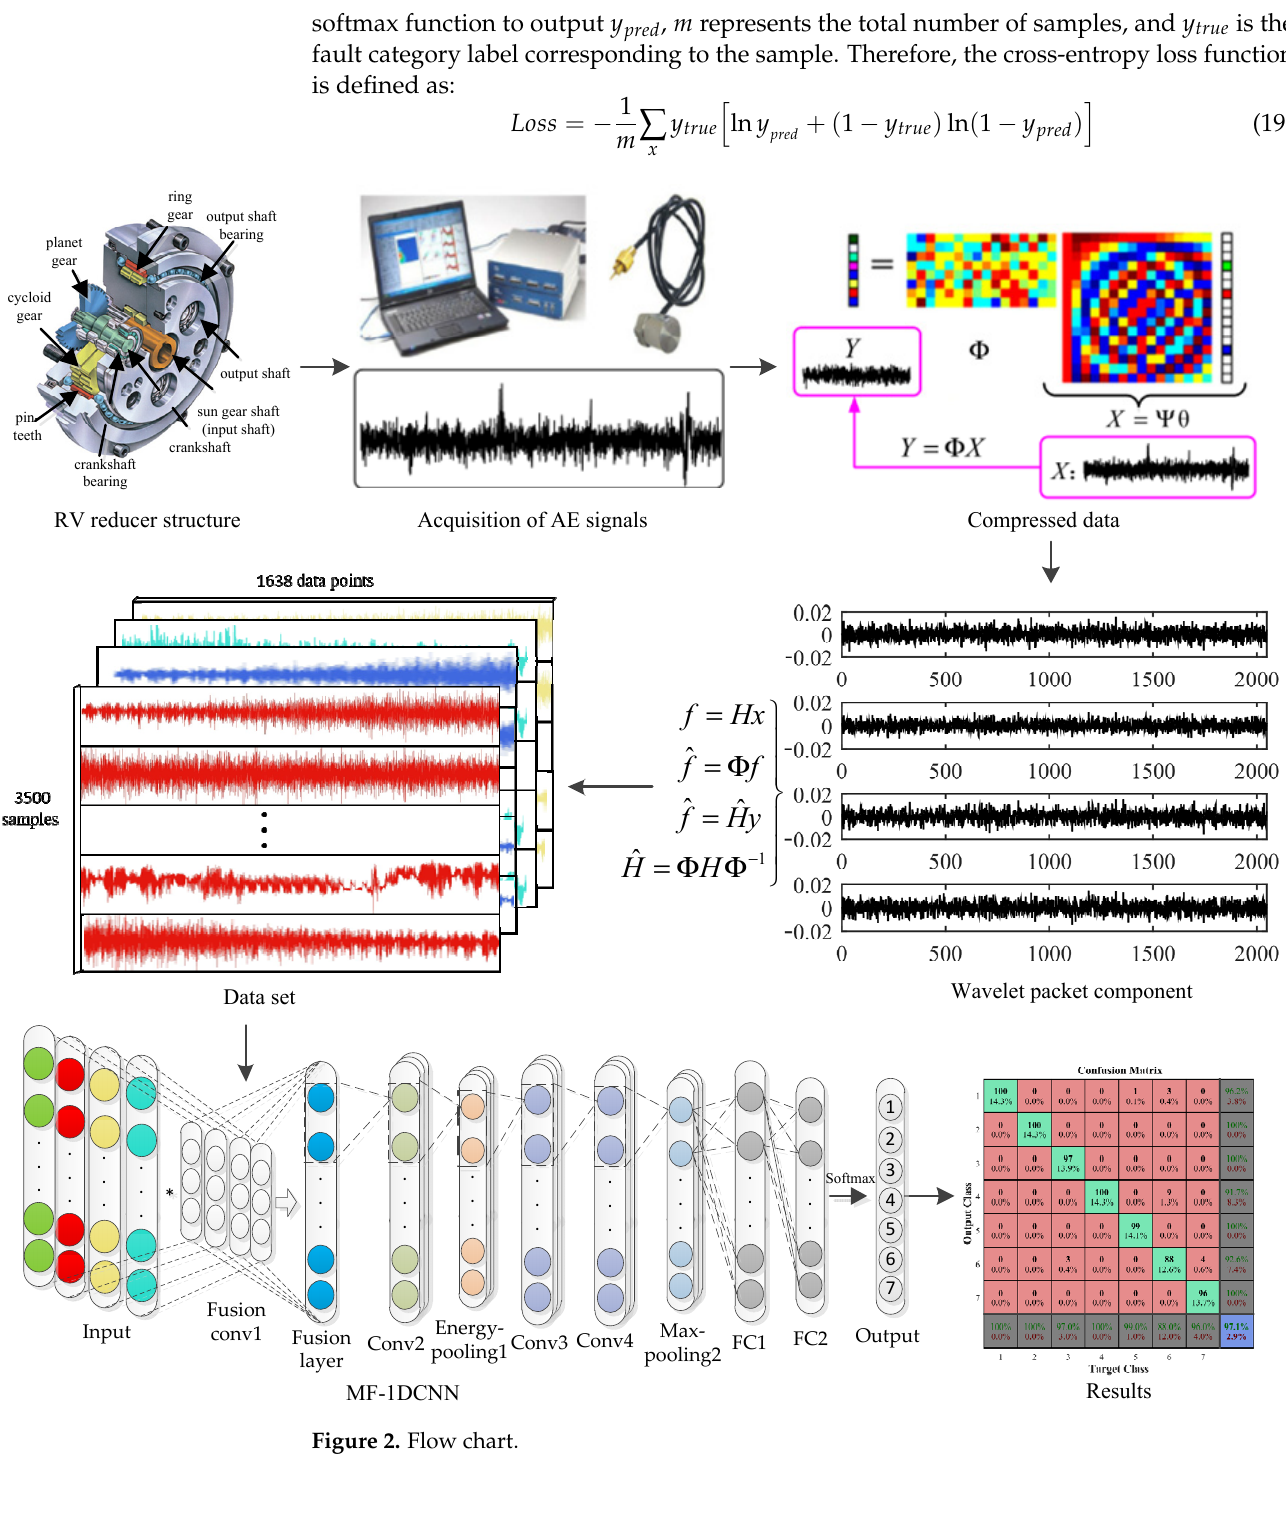
Figure 2. Flow chart.